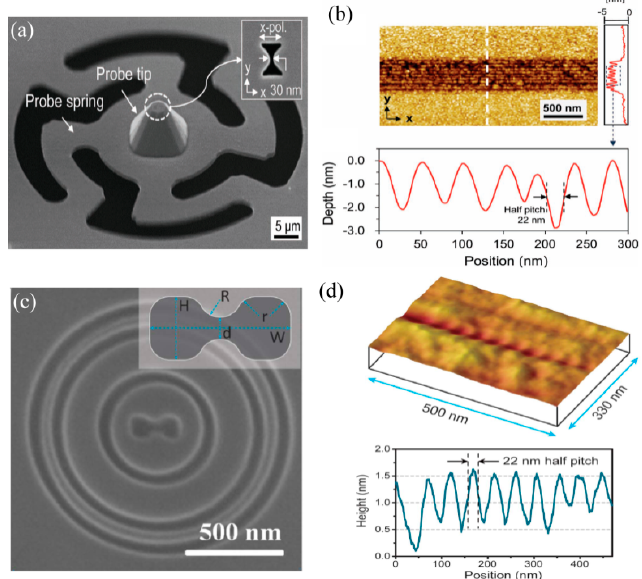
Figure 16. ( a ) SEM picture of circular contact probe with bowtie aperture for plasmonic lithography; ( b ) AFM image of resist pattern with half pitch 22 nm; ( c ) SEM picture of plasmonic lens consisting of a dumbbell-shaped aperture, a set of ring couplers (two inner rings) and a ring reflector (the outer ring); ( d ) Experimental results of resist pattern. Reproduced from: (a,b), [66], Copyright © 2012, WILEY; (c,d), [79], Copyright © 2011, NGP.